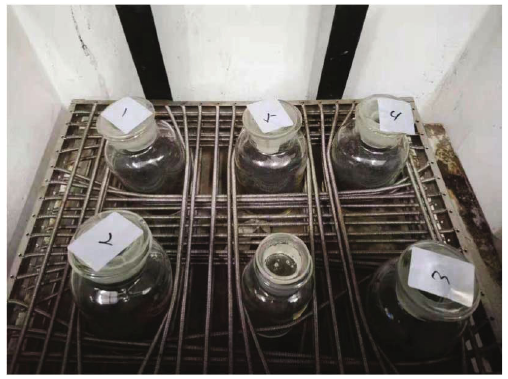
Figure 1: The experimental preparation